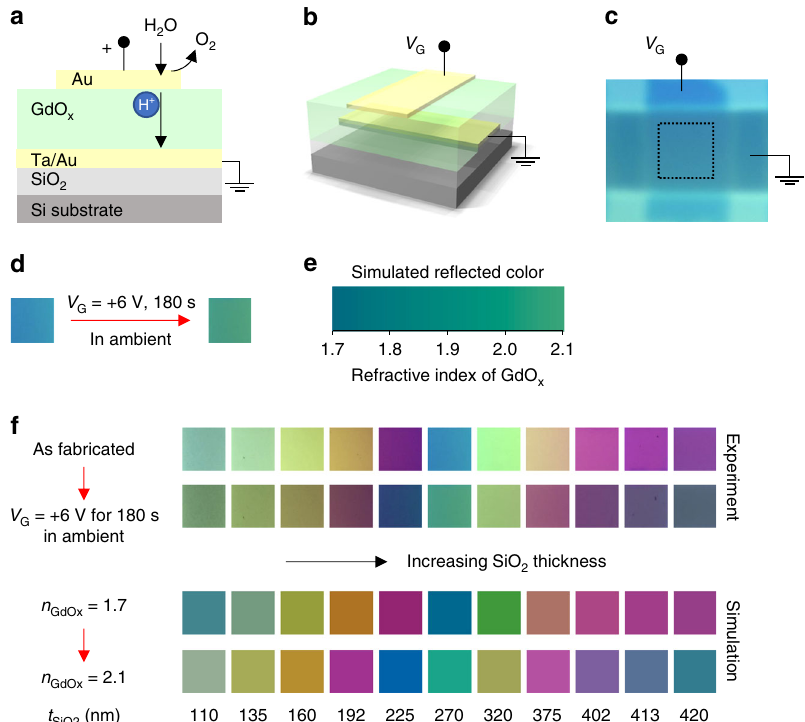
Fig. 3 Electrochemical switchable color from solid-state thin fi lms. a Schematic illustration of interference color-switching device. When a V G > 0 is applied, water from the ambient is dissociated and the protons move towards the bottom electrode and incorporate into GdO x fi lm. b Schematic illustration of interference color-switching device with a crossbar structure. c Optical image of a typical device as fabricated. Probes are landed on the top and bottom electrode. d Optical images of a device with 270 nm SiO 2 before and after voltage application in ambient. e Simulated re fl ected color of the device as a function of the refractive index of GdO x . f Optical images of devices and simulated colors with increasing SiO 2 thickness from the left (110 nm) to the right (420